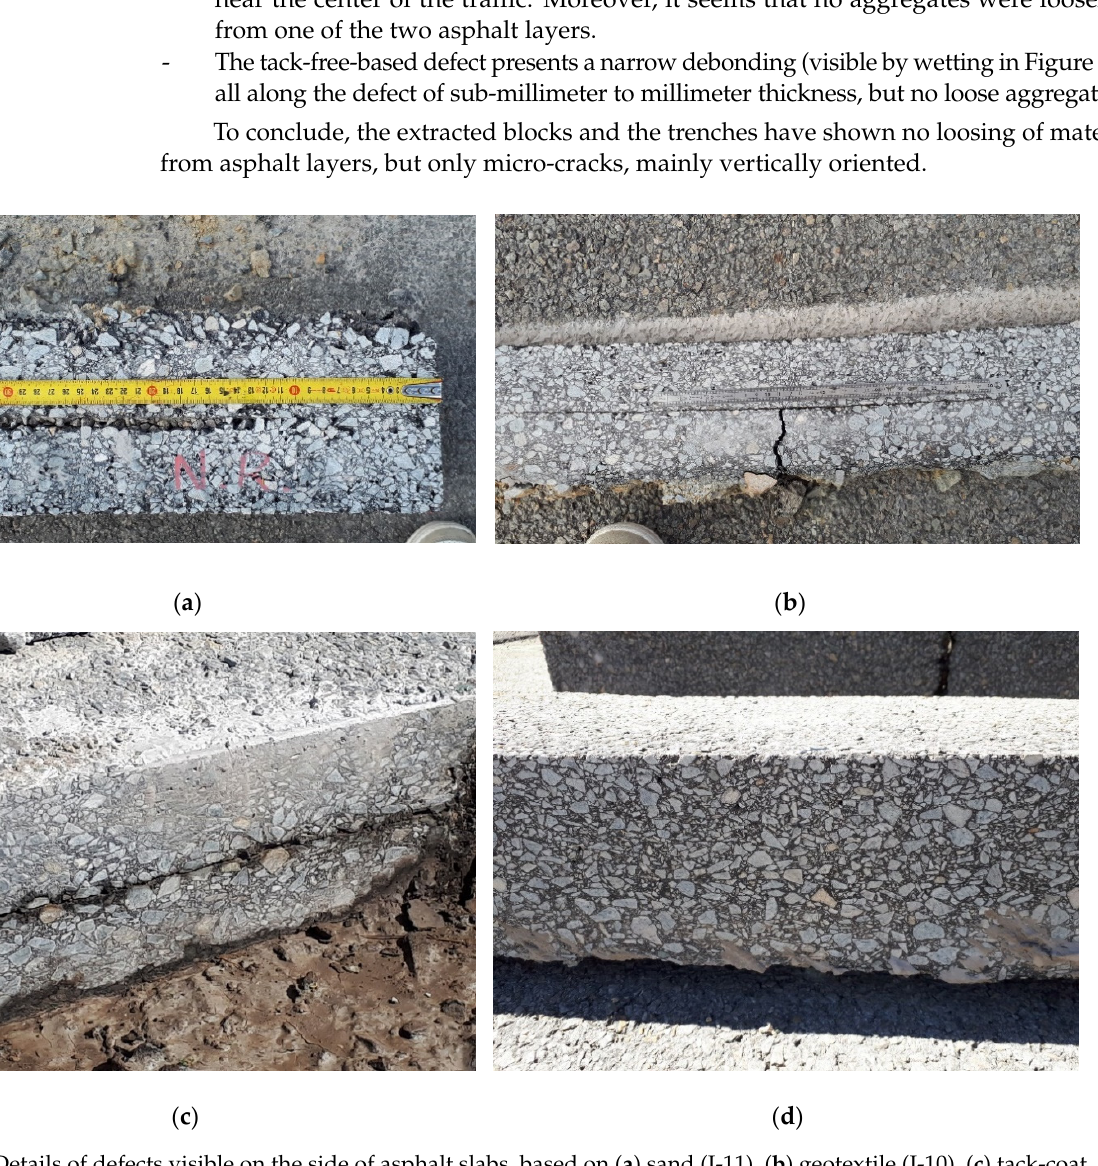
Figure 39. Transverse trenches and corresponding asphalt slabs of ( a ) defect I-10 and ( b ) defects I-12.